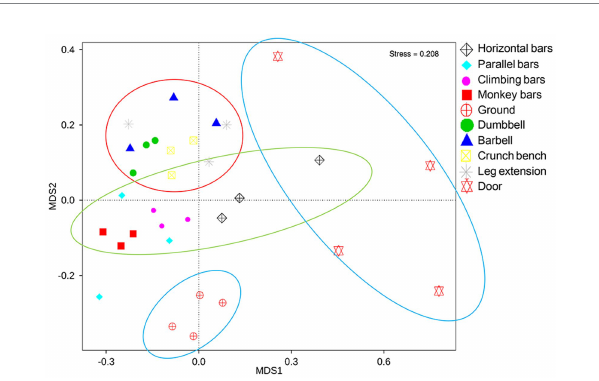
FIGURE 3 NMDS analysis of microbial community on the surfaces of gymnastic equipment. Red circle, represents indoor equipment; green circle, represents outdoor equipment; blue circle, represents